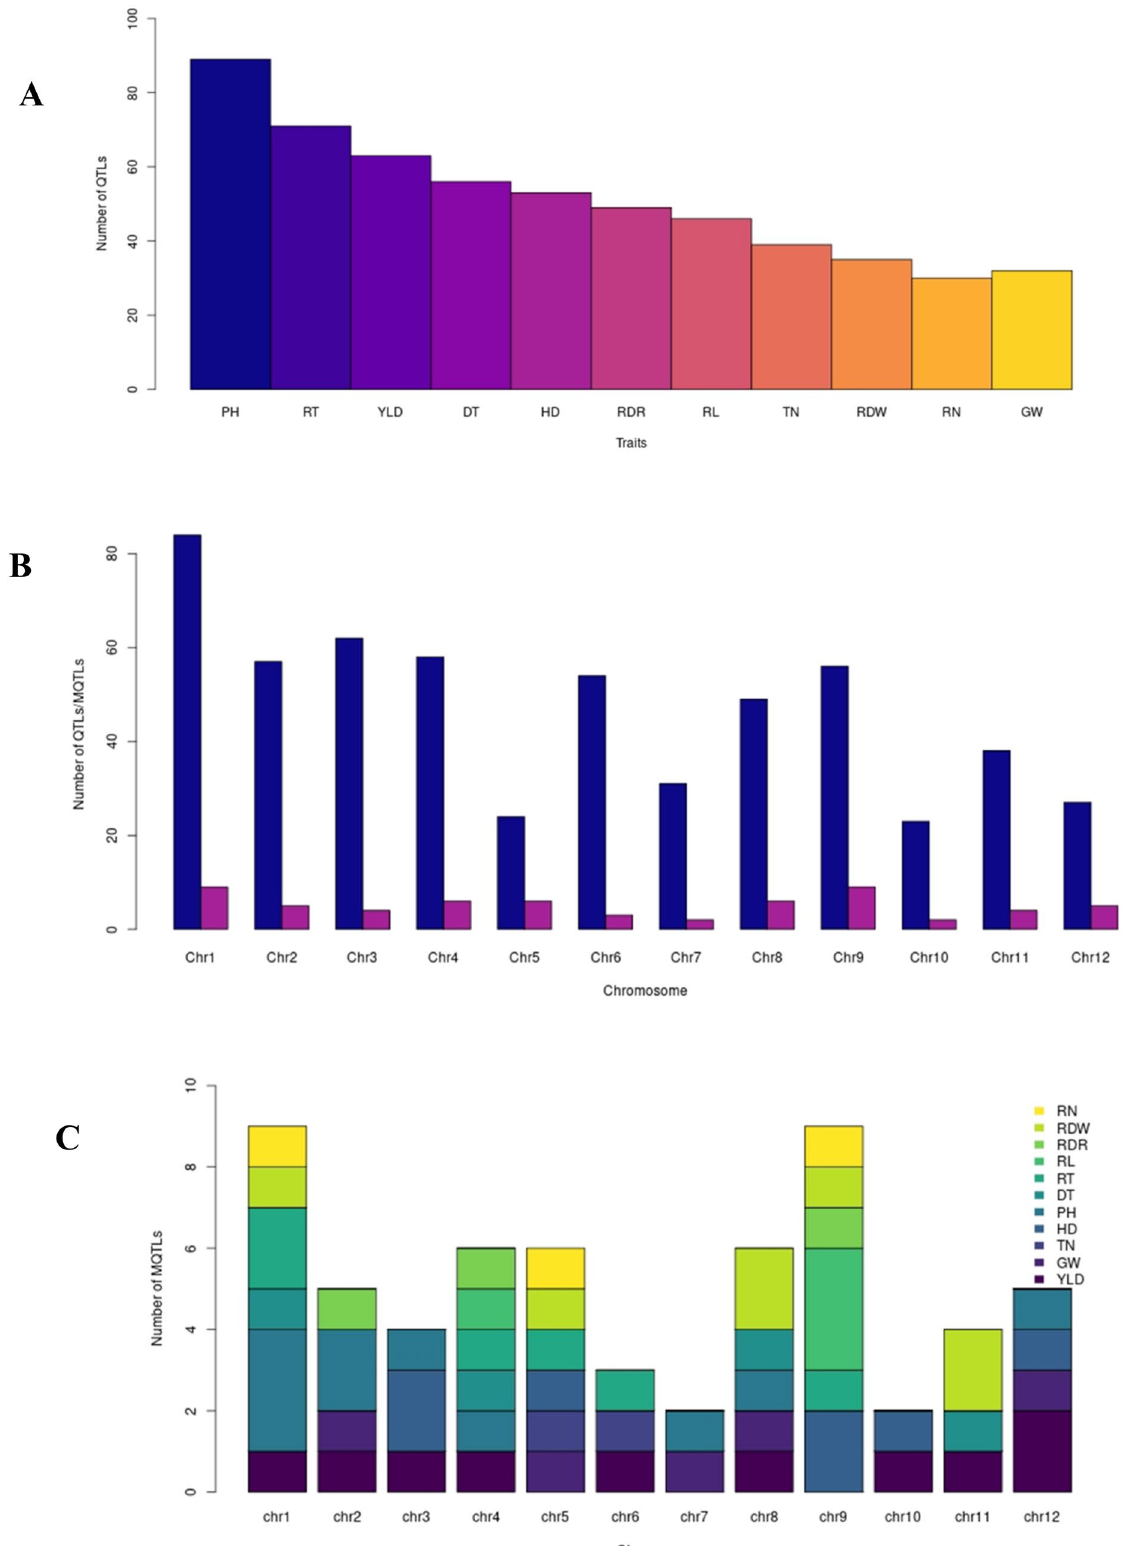
Figure 1. The number and distribution of QTLs and MQTLs. ( A ) The number of initial QTLs used in the MQTL analysis for YLD, HD, PH, GW, TN, DT, RT, RL, RDR, RDW and RN. ( B ) The distribution of QTLs and MQTLs on the twelve chromosomes of rice shown in dark blue and purple, respectively. ( C ) The number of MQTLs for different traits on each chromosome of